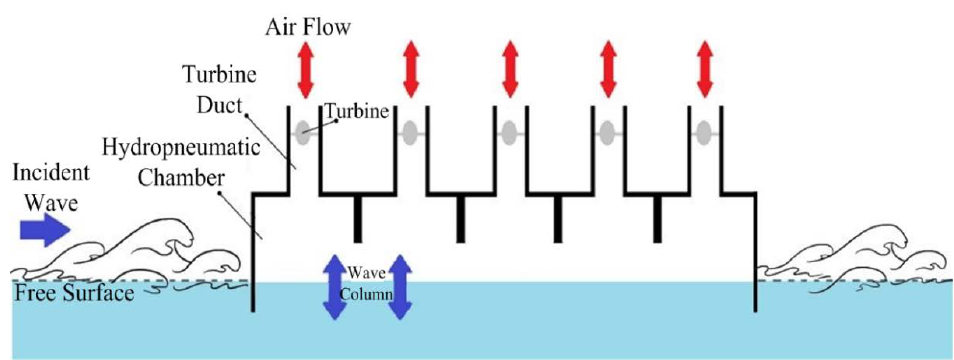
Figure 1. Principle of operation of an OWC